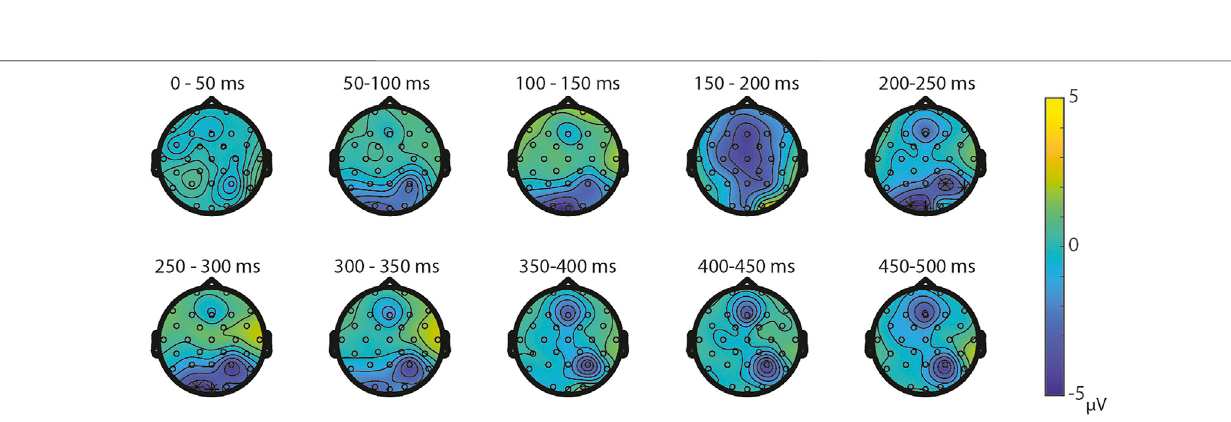
Frontiers in Education |